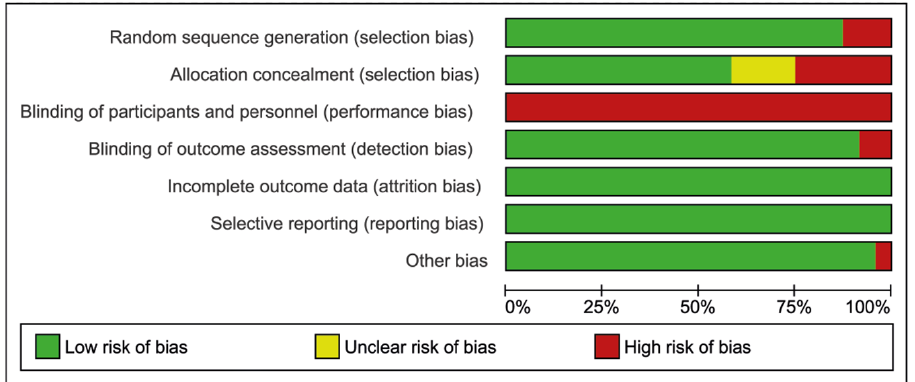
Figure 3. Risk of bias graph.